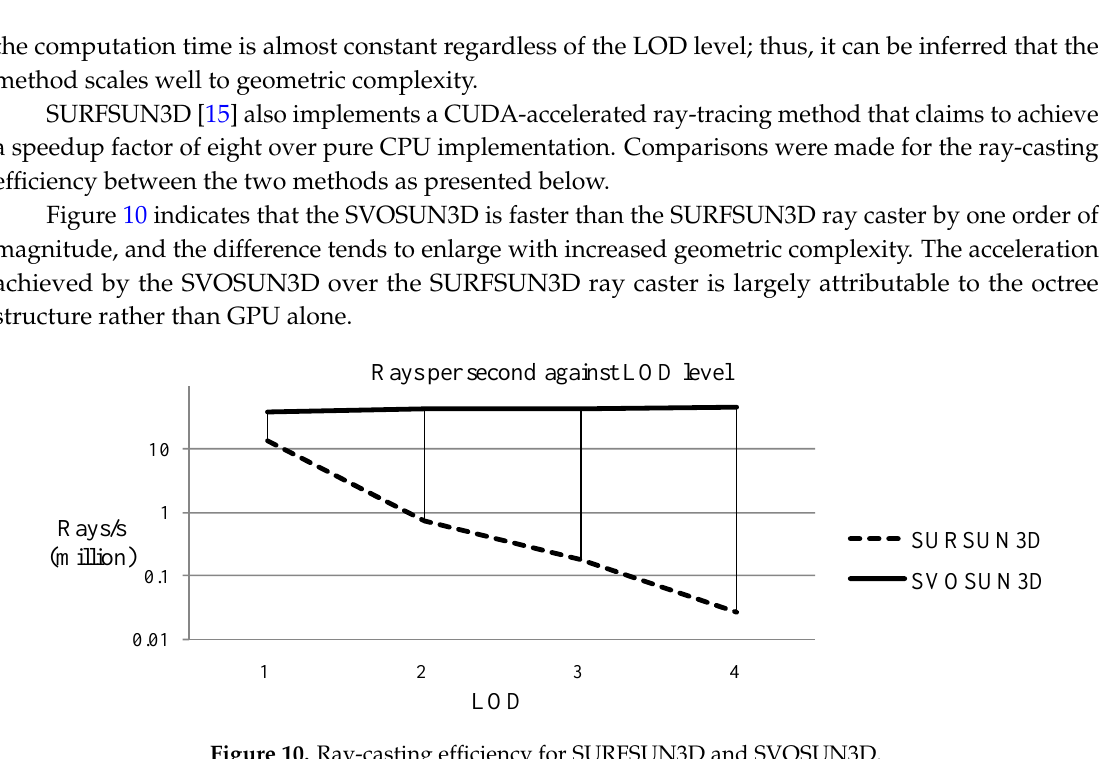
Figure 10. Ray-casting efficiency for SURFSUN3D and SVOSUN3D.